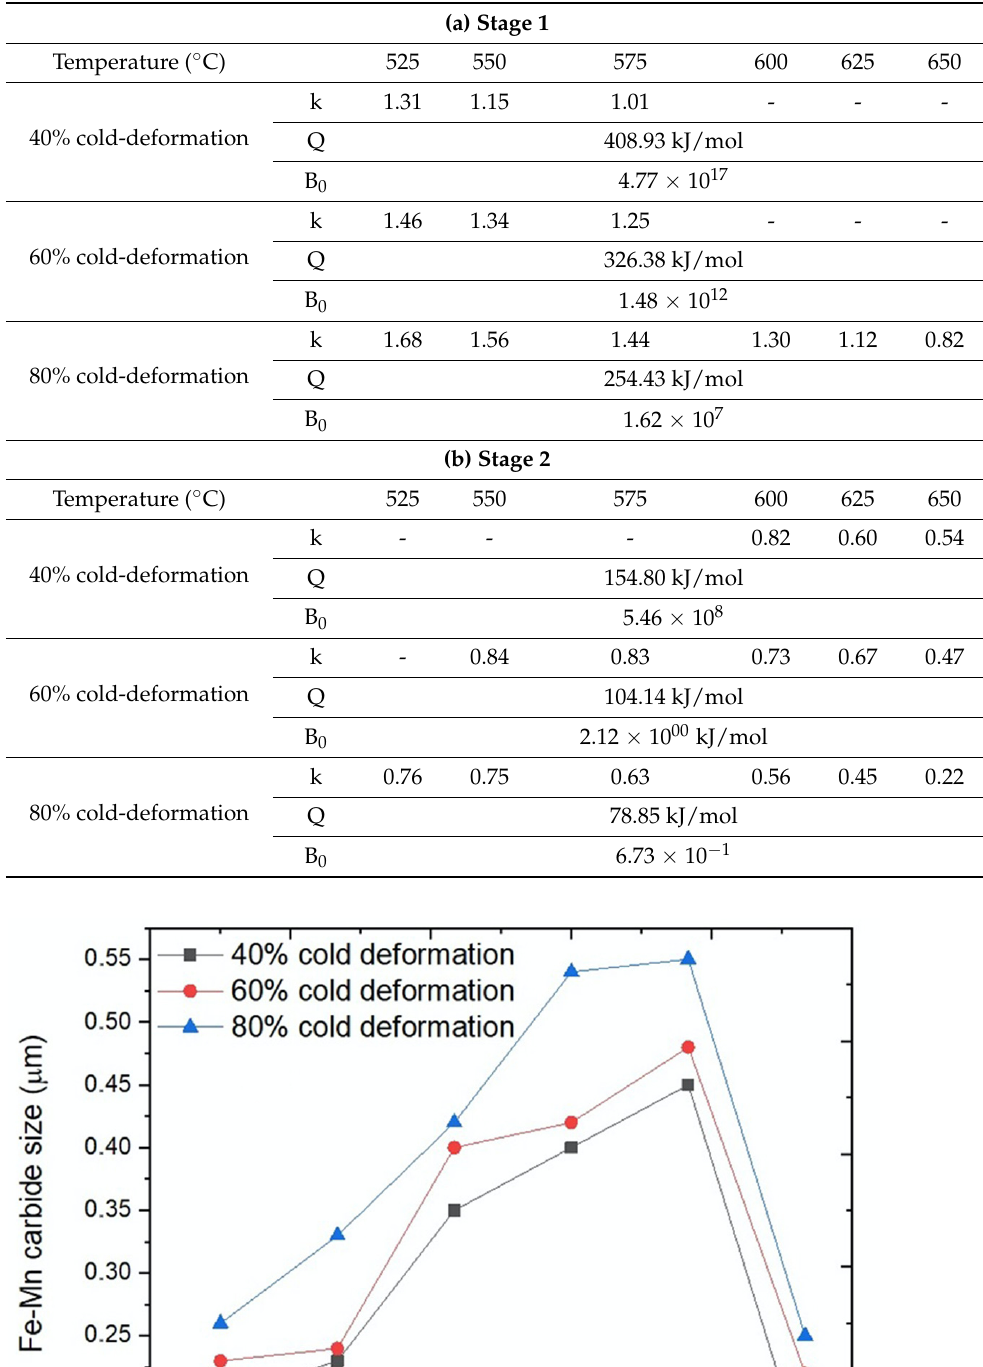
Table 2. JMAK parameters for Fe-Mn carbide.